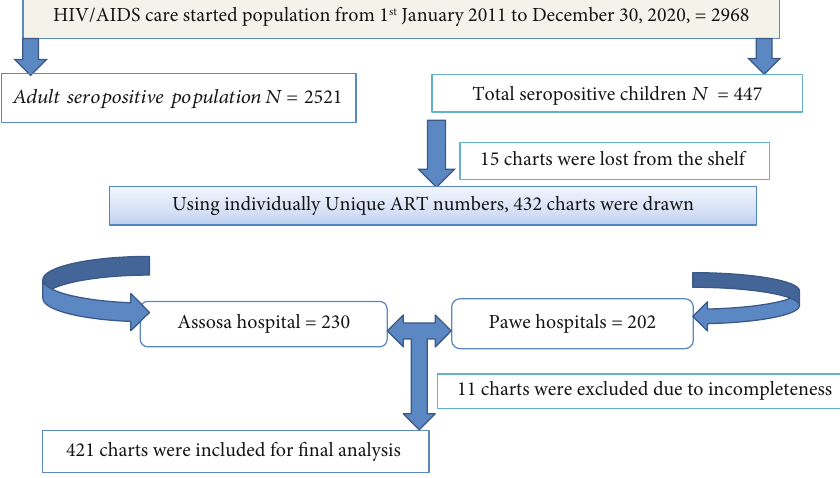
Figure 1: Schematic presentation of sampling procedure from the two general